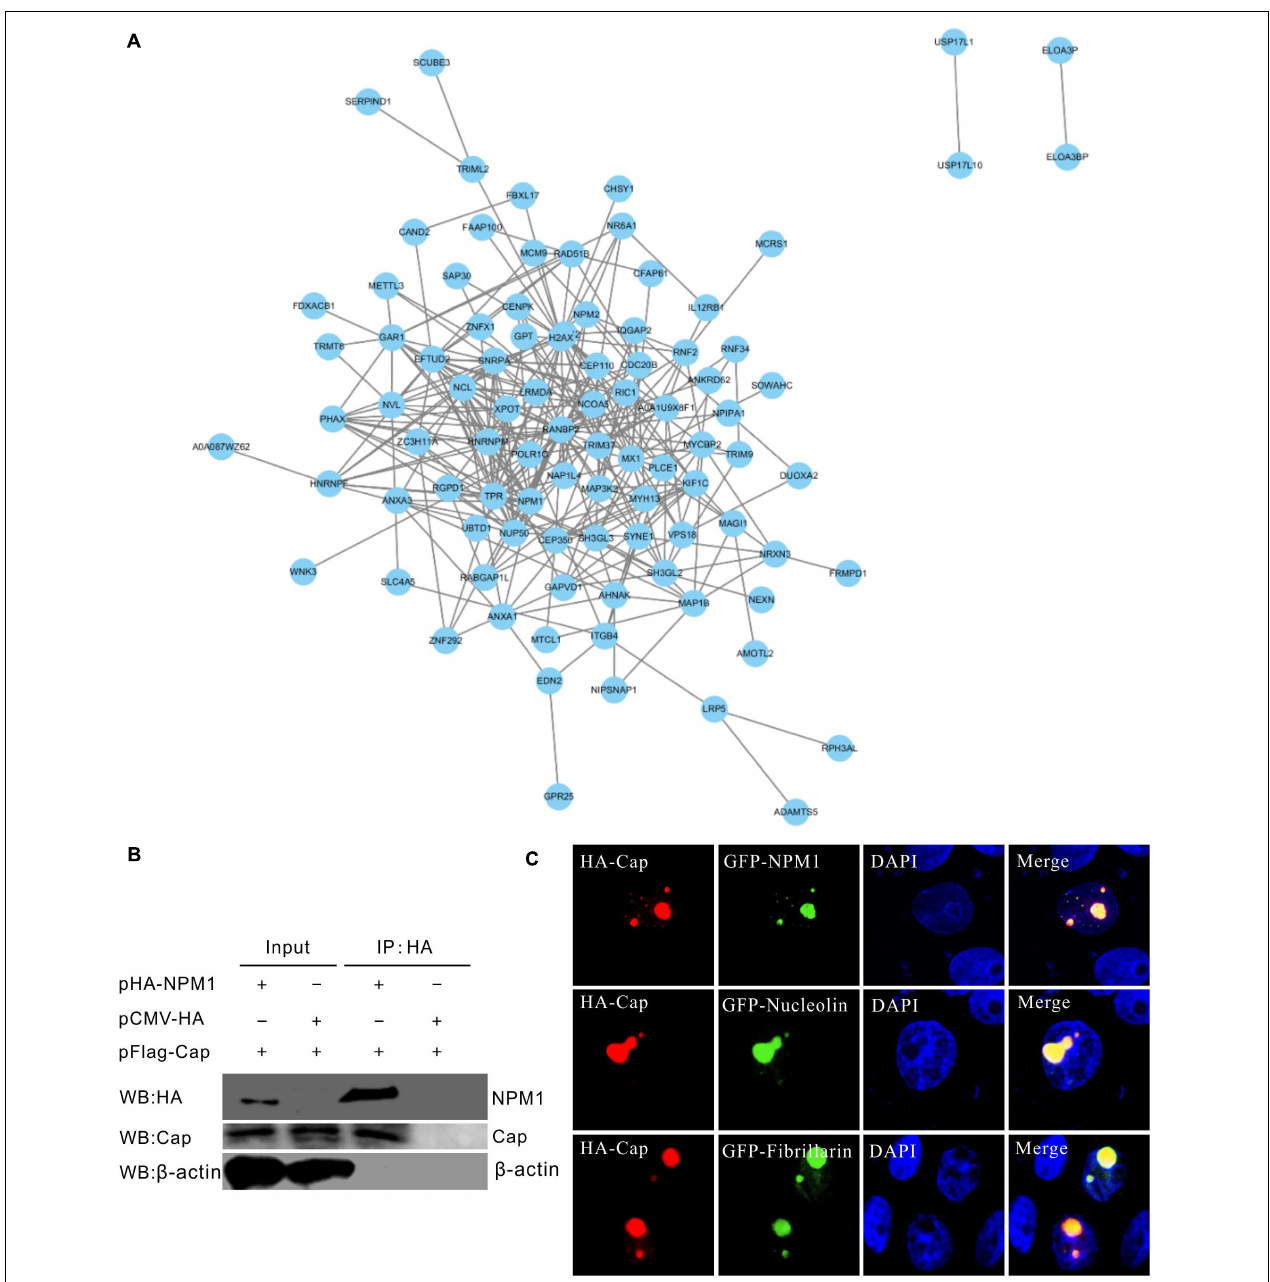
FIGURE 2 | Mapping and identification of protein interactions. (A) Mapping of protein-protein interactions (PPIs) network using STRING database. Top ranking PPIs were selected to map the interaction network. The PPIs network with PCV3 Cap was constructed by Cytoscape software. (B) Confirmation of interaction between PCV3 Cap and NPM1. HEK293T cells were co-transfected with plasmids expressing FLAG-Cap and HA-NPM1. Co-transfection with an empty vector was used as a negative control. Cell lysates were prepared at 24 h after transfection and immunoprecipitated with HA beads. Protein samples were separated by SDS-PAGE and detected with antibodies against FLAG and Cap by western blotting. (C) Colocalization of PCV3 Cap with NPM1 and nucleolar proteins. PK15 cells were co-transfected with plasmids expressing HA-Cap with NPM1-GFP, nucleolin-GFP, and fibrillarin-GFP, respectively. The cells were incubated with the antibodies corresponding to the HA tag at 24 h post-transfection, and followed by the Alexa Fluor 568-conjugated secondary antibodies (red). Nuclei were stained with DAPI (blue).